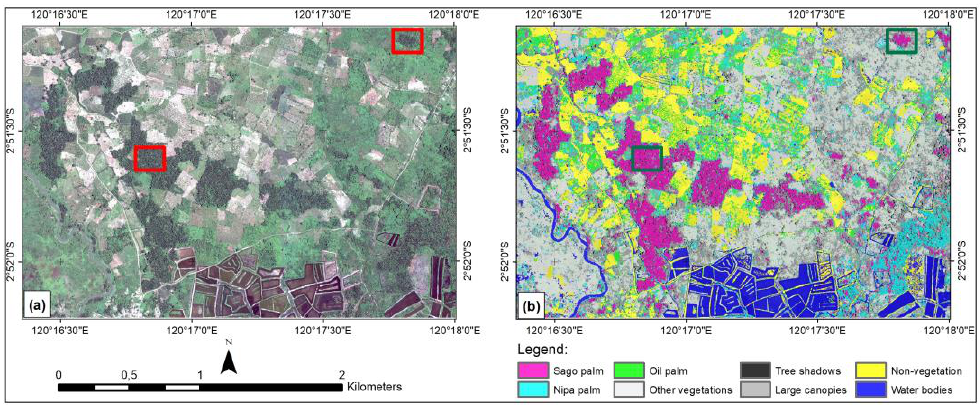
Figure 5. ( a ) Natural color composite of the whole Pleiades-1A test image; and ( b ) SVM classified image using eight features and showing eight classes.